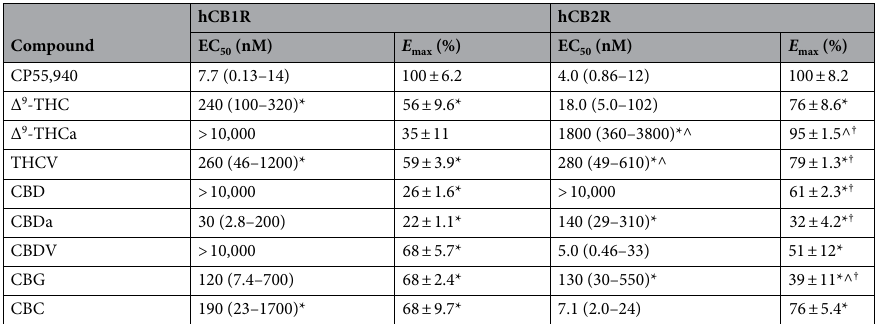
Table 2. hCB1R- or hCB2R-dependent inhibition of FSK-stimulated cAMP accumulation. hCB1R- or hCB2R-dependent inhibition of FSK-stimulated cAMP accumulation was quantified in HitHunter CHO cells stably expressing hCB1R or hCB2R and treated with compounds for 90 min. Data were fit to a variable slope (4 parameter) non-linear regression in GraphPad (v. 8). n ≥ 6 independent experiments performed in triplicate. E Max refers to the top of the concentration–response curve. Data are expressed as nM with 95% CI or %CP55,940 response, mean ± SEM. *p < 0.05 compared to CP55,940 within receptor; ^p < 0.05 compared to ∆ 9 -THC within receptor; † p < 0.05 compared to hCB1R within compound; as determined via non-overlapping 95% CI or one-way ANOVA followed by Tukey’s post-hoc test. Corresponding graphs are presented in Figs. 3 and 6.